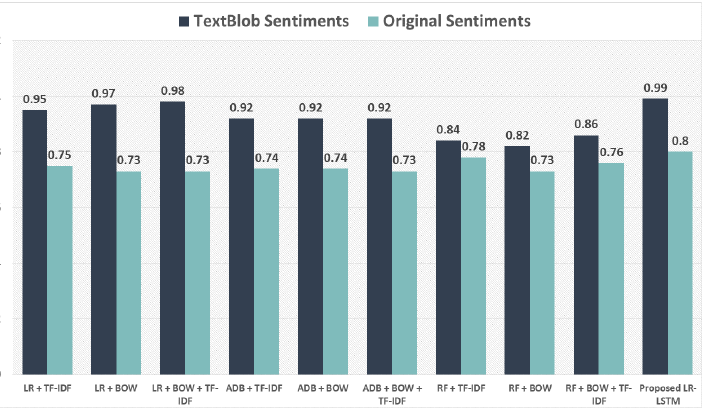
Figure 5. Accuracy score of classifiers with TextBlob sentiments and original sentiments (LR + TF-IDF refers to an LR model trained on features extracted by TF-IDF; the same goes for other